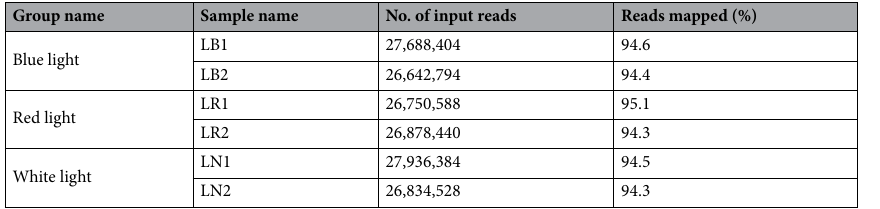
Table 3. Number of reads aligned to the assembled transcriptome.